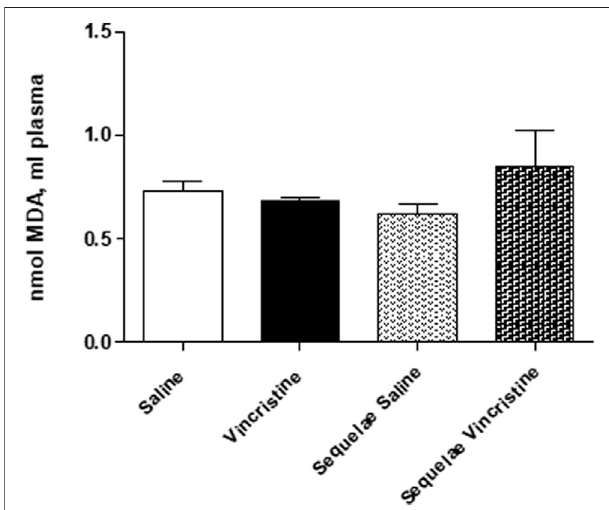
FIGURE 11 | Effect of vincristine treatment and 2-week suspension of treatment(sequelae)onmalondialdehyde(MDA)inplasma.Datarepresentthe mean ± SEM, n (cid:2) 4 – 6 animals per experimental group. A one-way ANOVA followedbyBonferroni ’ smultiplecomparisontestwasusedforstatistical